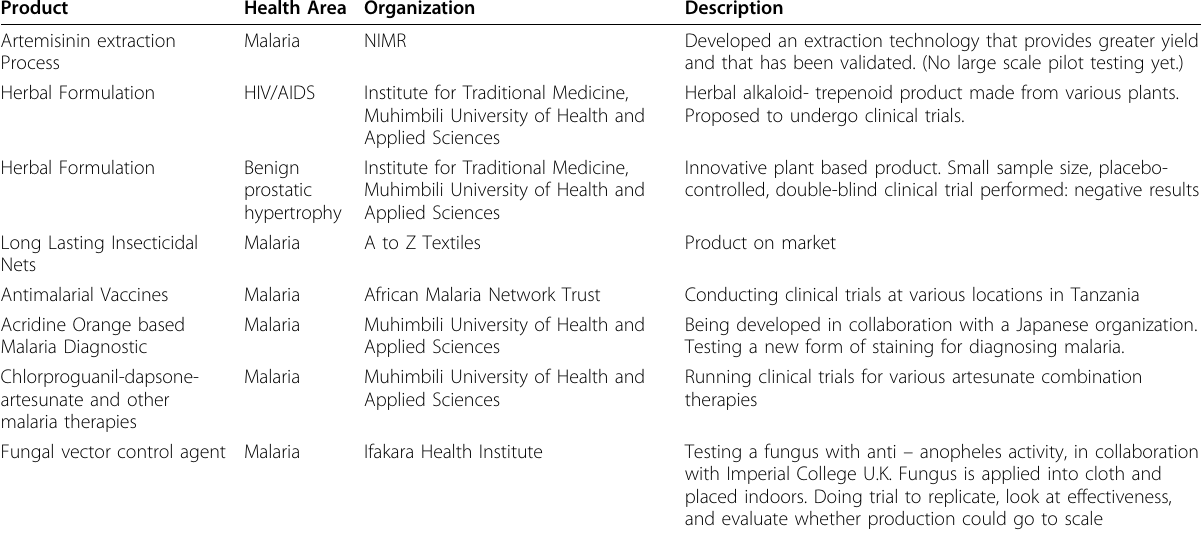
Table 1 Products and processes being developed in Tanzanian institutions